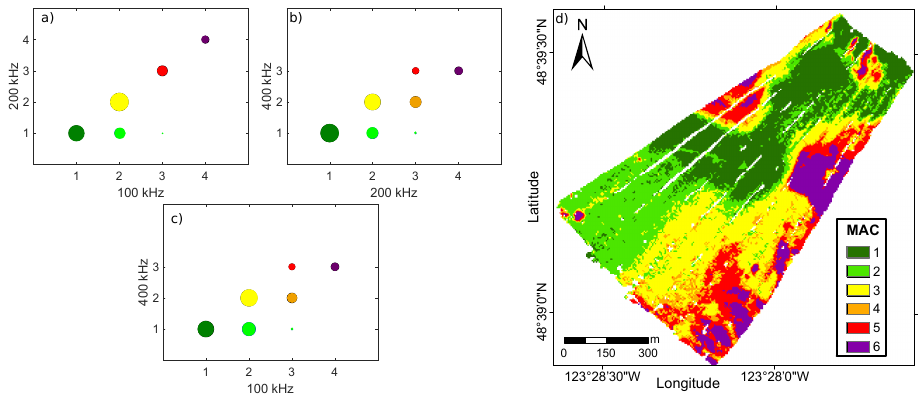
Figure 14. Multispectral classification results of the Patricia Bay dataset. MAC revealed by the AC combinations of ( a ) 100 and 200, ( b ) 200 and 400, and ( c ) 100 and 400 kHz. The colors indicate the different MACs. ( d ) MAC map with spatial resolution of 5m by